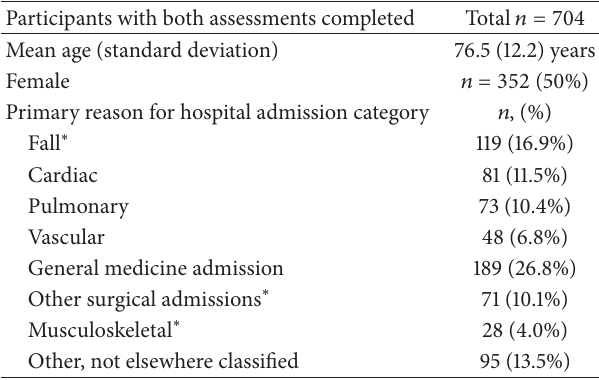
Table 1: Demographic and clinical characteristics of the